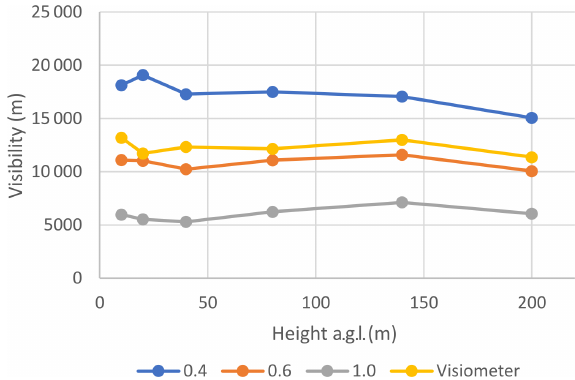
Figure 8. Visibility computed from all six transfer functions from Fig. 7 for three different backscatter values (in units of 10 − 6 m − 1 sr − 1 ) and temporal mean (15 February 2018 to 29 Febru- ary 2020) of visiometer readings between visibilities of 4 and 19.5km as a function of